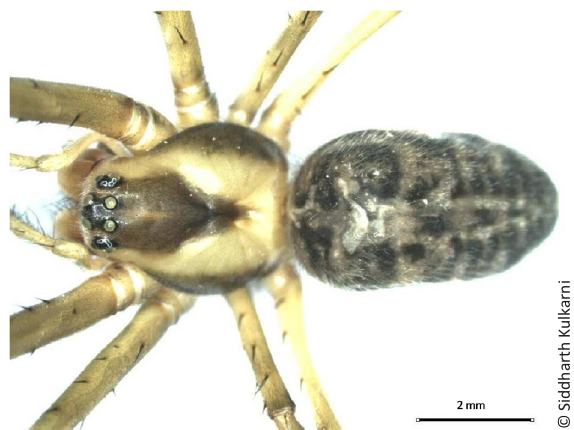
Figure 1. Location of type-locality in Maharashtra Image 1. Tylorida sataraensis sp. nov. female holotype - Habitus